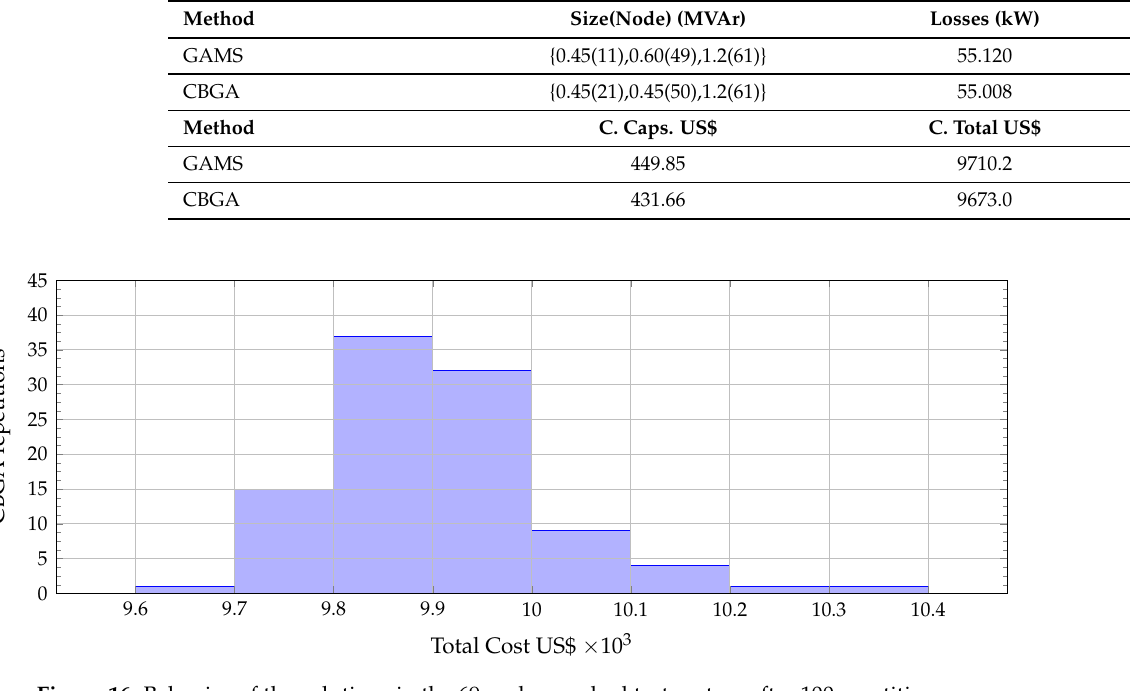
Figure 16. Behavior of the solutions in the 69 nodes meshed test system after 100 repetitions.